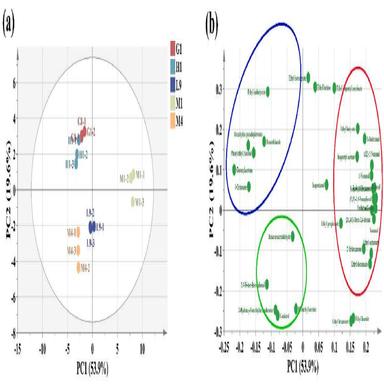
PCA analysis of aroma compounds in baijiu. (a) Score plot; (b) load plot.